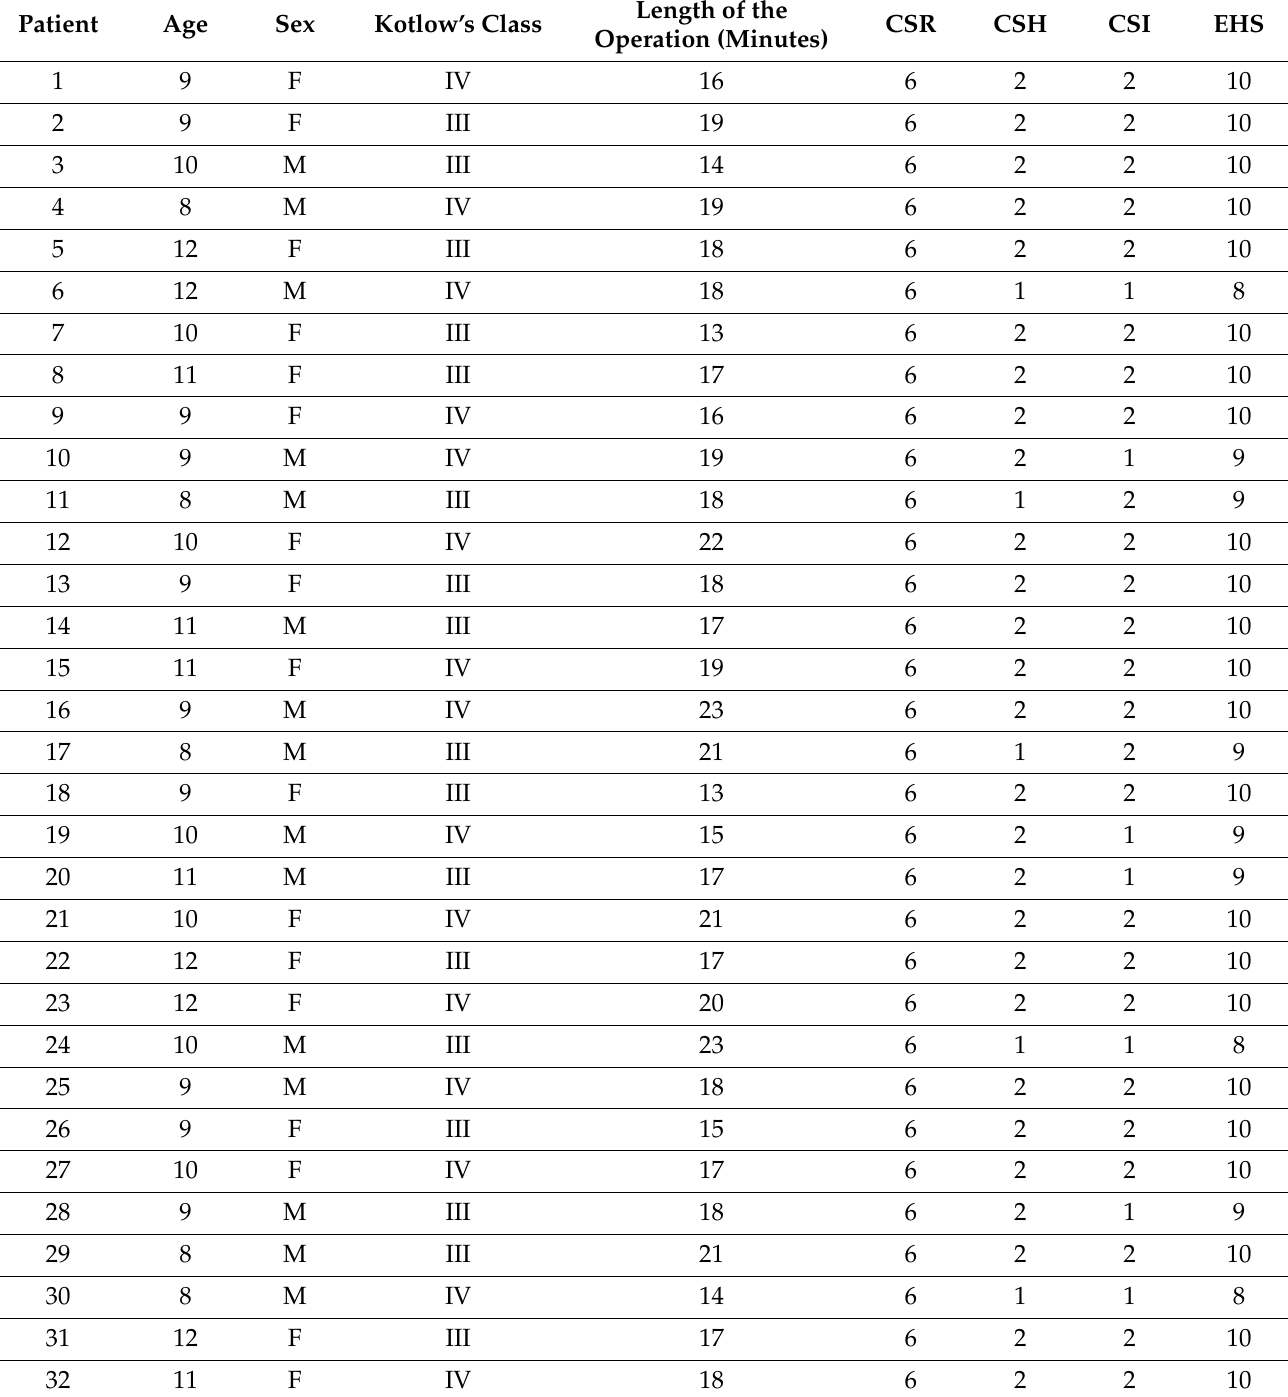
Table 3. Clinically recorded EHS parameters for patients of Group